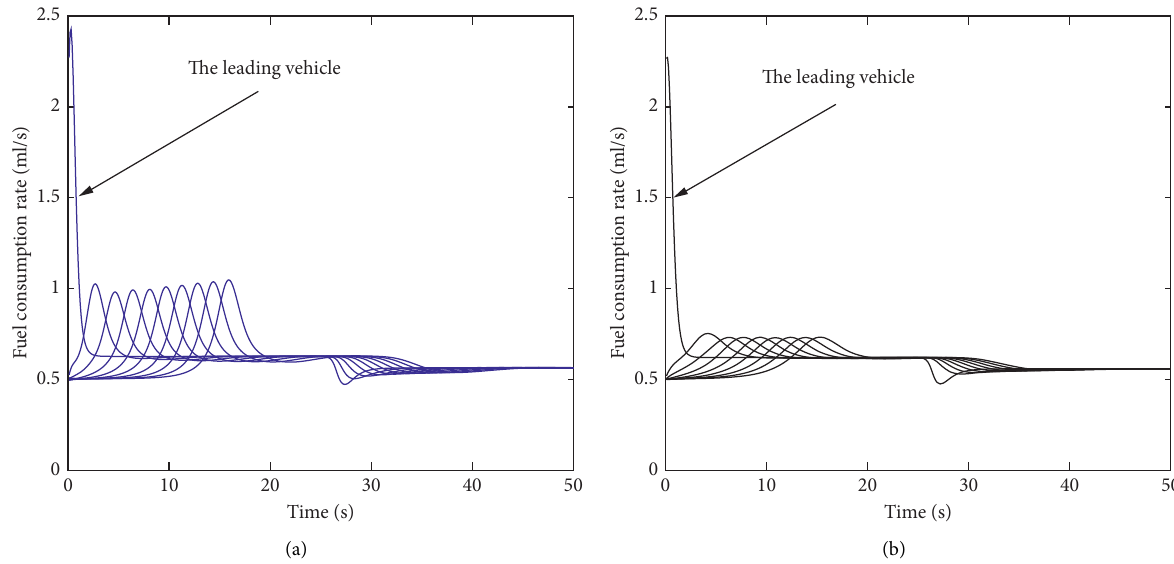
Figure 13: Fuel consumption of each vehicle during departure and arrival process simulated by the (a) AFVD model ( T � 0, p � 0) and (b) AAFVD model ( T � 0.1, p � 0 .